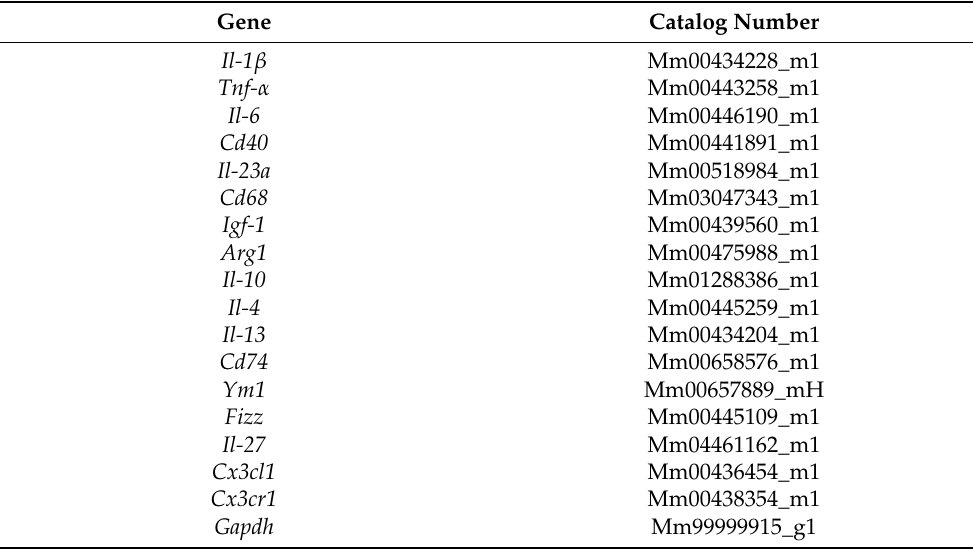
Table 1. A list of genes (with corresponding catalog numbers of TaqMan probes) examined in organotypic hippocampal cultures (OHCs) that were obtained from the offspring of wild type (WT) and FPR2 − / − (KO) mice using qRT-PCR. Gapdh was used as the reference gene. Gene Catalog Number Il-1